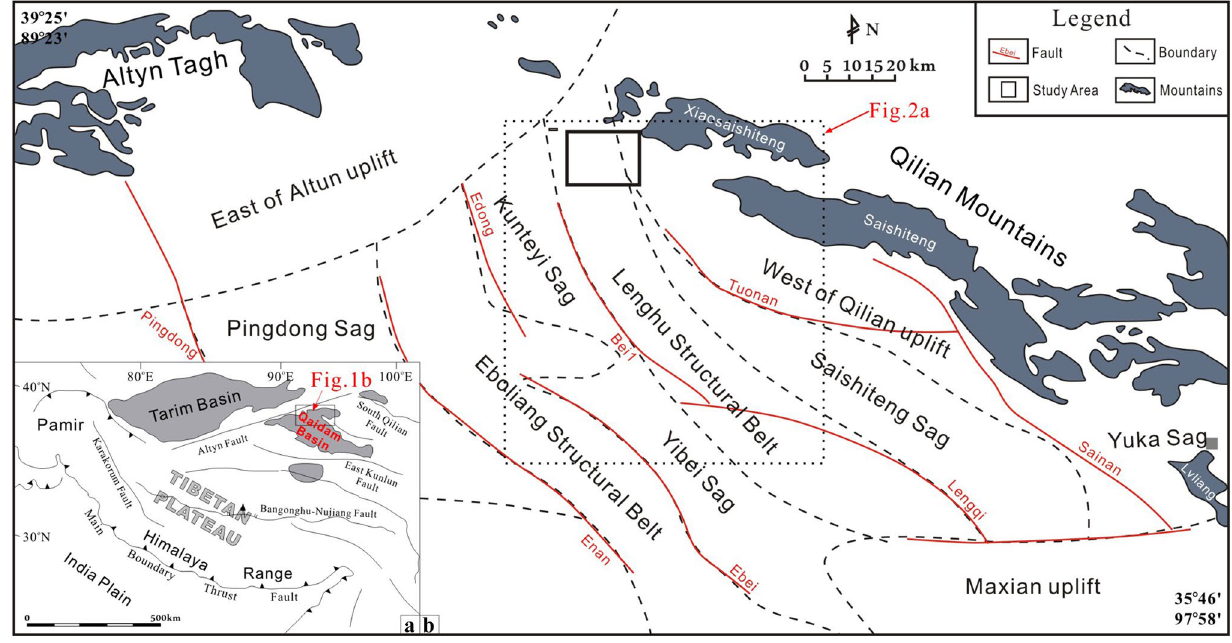
Fig. 1 a The regional geological setting and location of Qaidam Basin. The black rectangle indicates the study area shown in b. b Tectonic zones in the northern margin of Qaidam Basin (modified from Ref. Tian et al. 2018; Zhao et al.